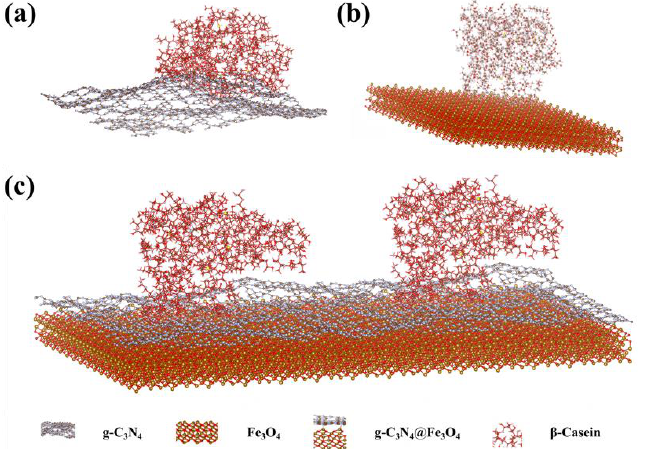
Figure 5. DFT coordination mechanism of ( a ) Fe 3 O 4 , ( b ) g-C 3 N 4 and ( c ) g-C 3 N 4 @Fe 3 O 4 on β -Casein, respectively.